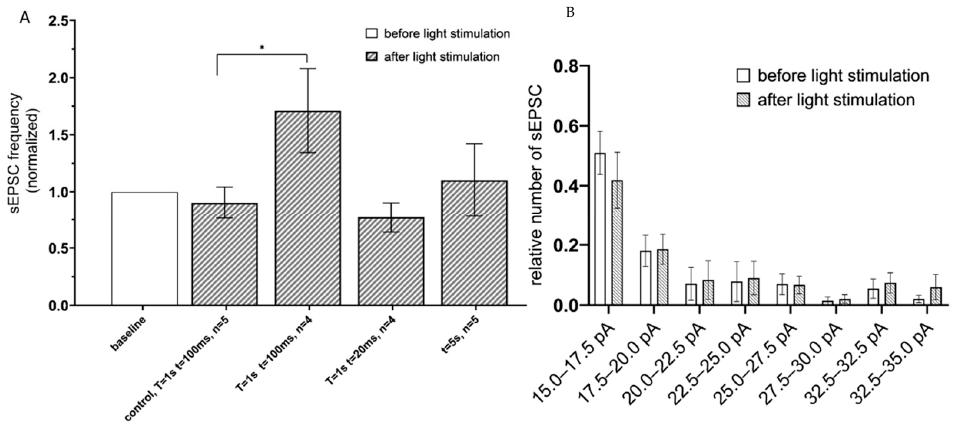
Figure 3. sEPSC changes in response to astrocyte activation using Opto-a1AR-EYFP. ( A ) Values of the normalized frequencies of sEPSC in the CA1 hippocampal neurons after light activation (t = 20 ms, T = 20 ms; t = 20 ms, T = 1 s; t = 100 ms, T = 1 s; continuously t = 5 s) of astrocytes expressing Opto-a1AR-EYFP. The data are presented as the mean ± SEM, *: p < 0.05. ( B ) Distribution of sEPSC amplitudes before and after optogenetic activation of astrocytes expressing Opto-a1AR-EYFP on the membrane. The data are presented as an average ± SEM.